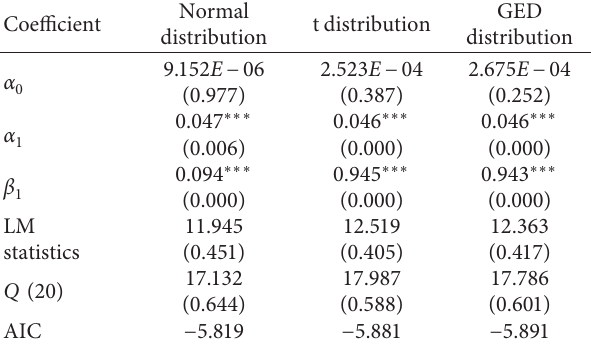
Table 5: GARCH (1, 1) fitting results.